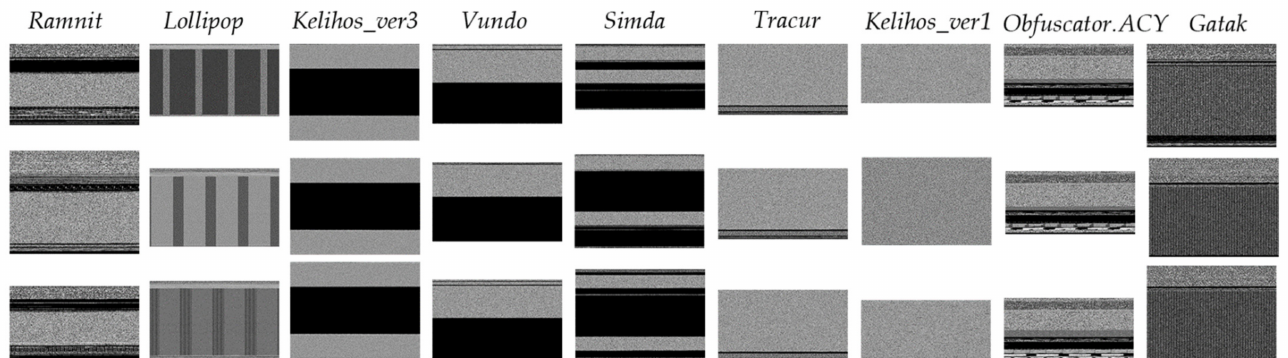
Figure 4. Image created from the BYTE files of the malware samples in MMCC dataset. It can be seen that images from different software families have distinct texture features and the same malware family samples are very